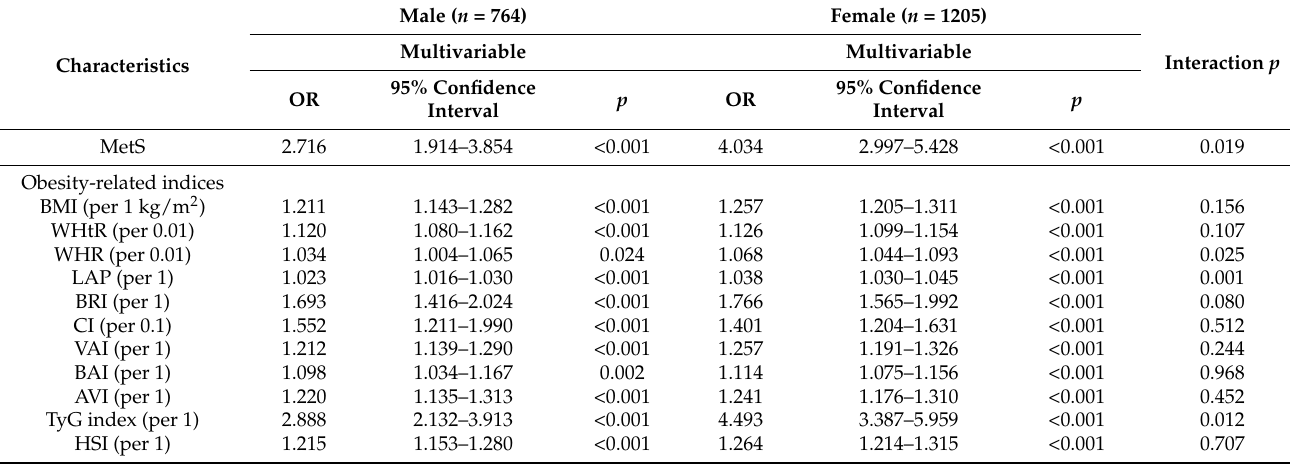
Table 2. Association of MetS and obesity-related indices with fatty liver using multivariable logistic regression analysis.